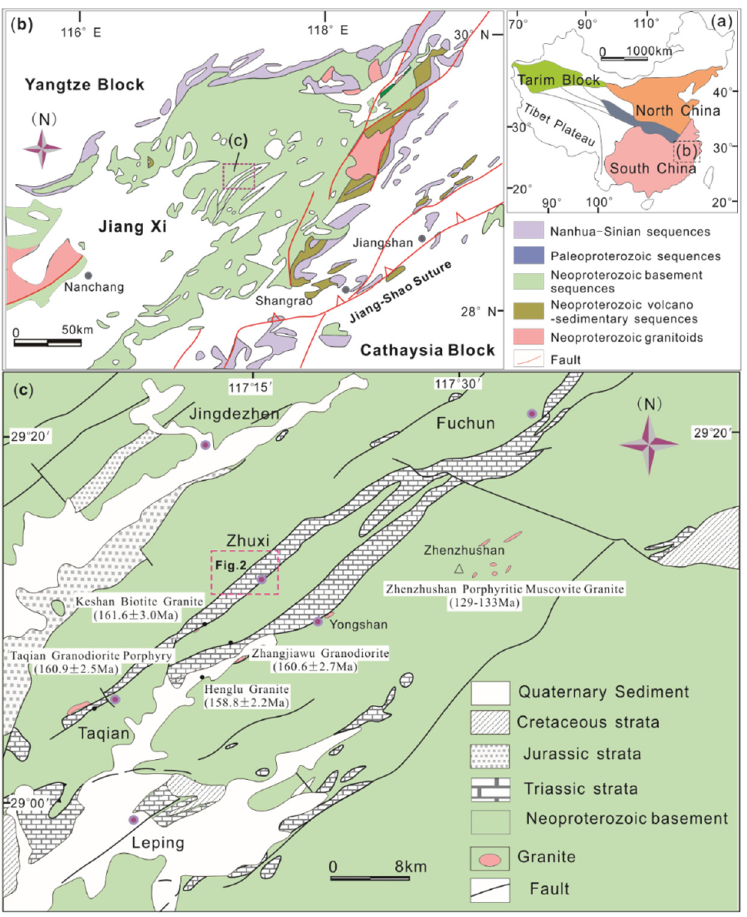
Figure 1. Geological map of the Jingdezhen area of the South China Block. ( a ) Inset shows the location of the South China Block. ( b ) Sketch tectonic map of the Jingdezhen and adjacent areas (modified from [34]). ( c ) Geological map of the Zhuxi area (modified from the [35]).